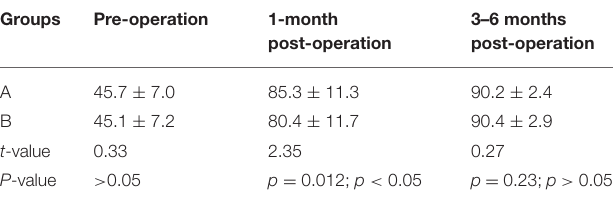
TABLE 2 | Comparison of Harris Hip scores between the two groups pre- and post-operation ( χ 2 ± S, score/min).